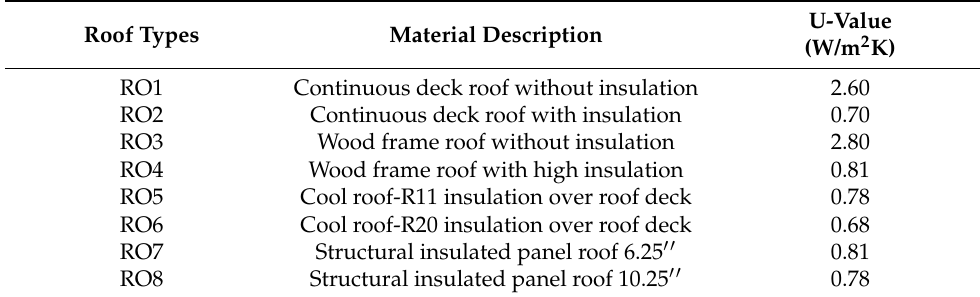
Figure 2. Different types of walls for office and warehouse buildings. ( a ) WO2: Masonry wall with insulation; ( b ) WO3: Wood wall without insulation; ( c ) WO4: Wood wall with insulation; ( d ) WO5: Straw bale wall; ( e ) WO6: Structurally insulated panel; ( f ) WO8: Insulated concrete foam; ( g ) WH1: Metal frame wall without insulation; ( h ) WH2: Metal frame wall with insulation. Table 6. Different types of roof materials for office building.